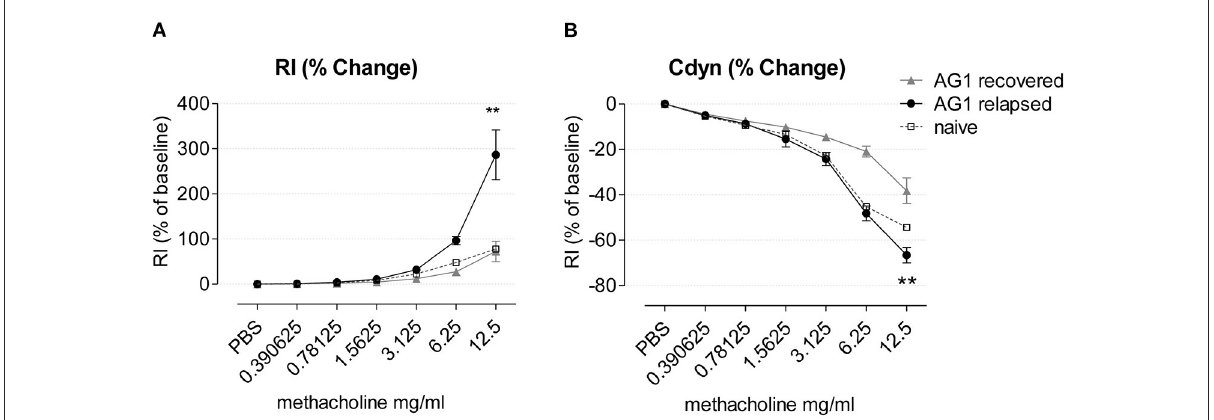
FIGURE9 Airway hyperresponsiveness of AG1-immunized mice during recovery and disease relapse 24h after RWP challenge. (A) Airway resistance (RI) and (B) Compliance (Cdyn) of mice during recovery and disease relapse (24h after RWP challenge) in response to methacholine expressed as % of baseline in response to increasing doses of aerosolized methacholine. Data are presented as mean ± SEM and are representative of at least two experiments; n = 3–4 . Asterisks indicate a significant difference between recovered and RWP rechallenged groups, ** p < 0.01 , t -test of the area under the curve